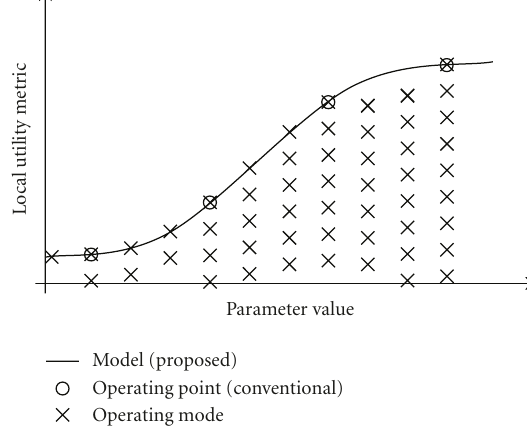
Figure 4: Visualization of operating modes.